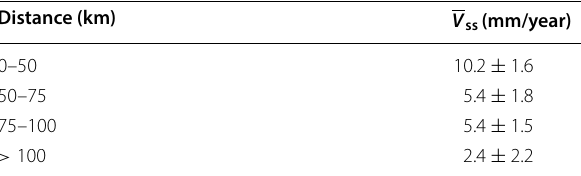
Table 2 Mean strike-slip components of the Xolapa sliver motion ( V ss ) for different distances from the trench calculated using data from the Global CMT Distance (km)